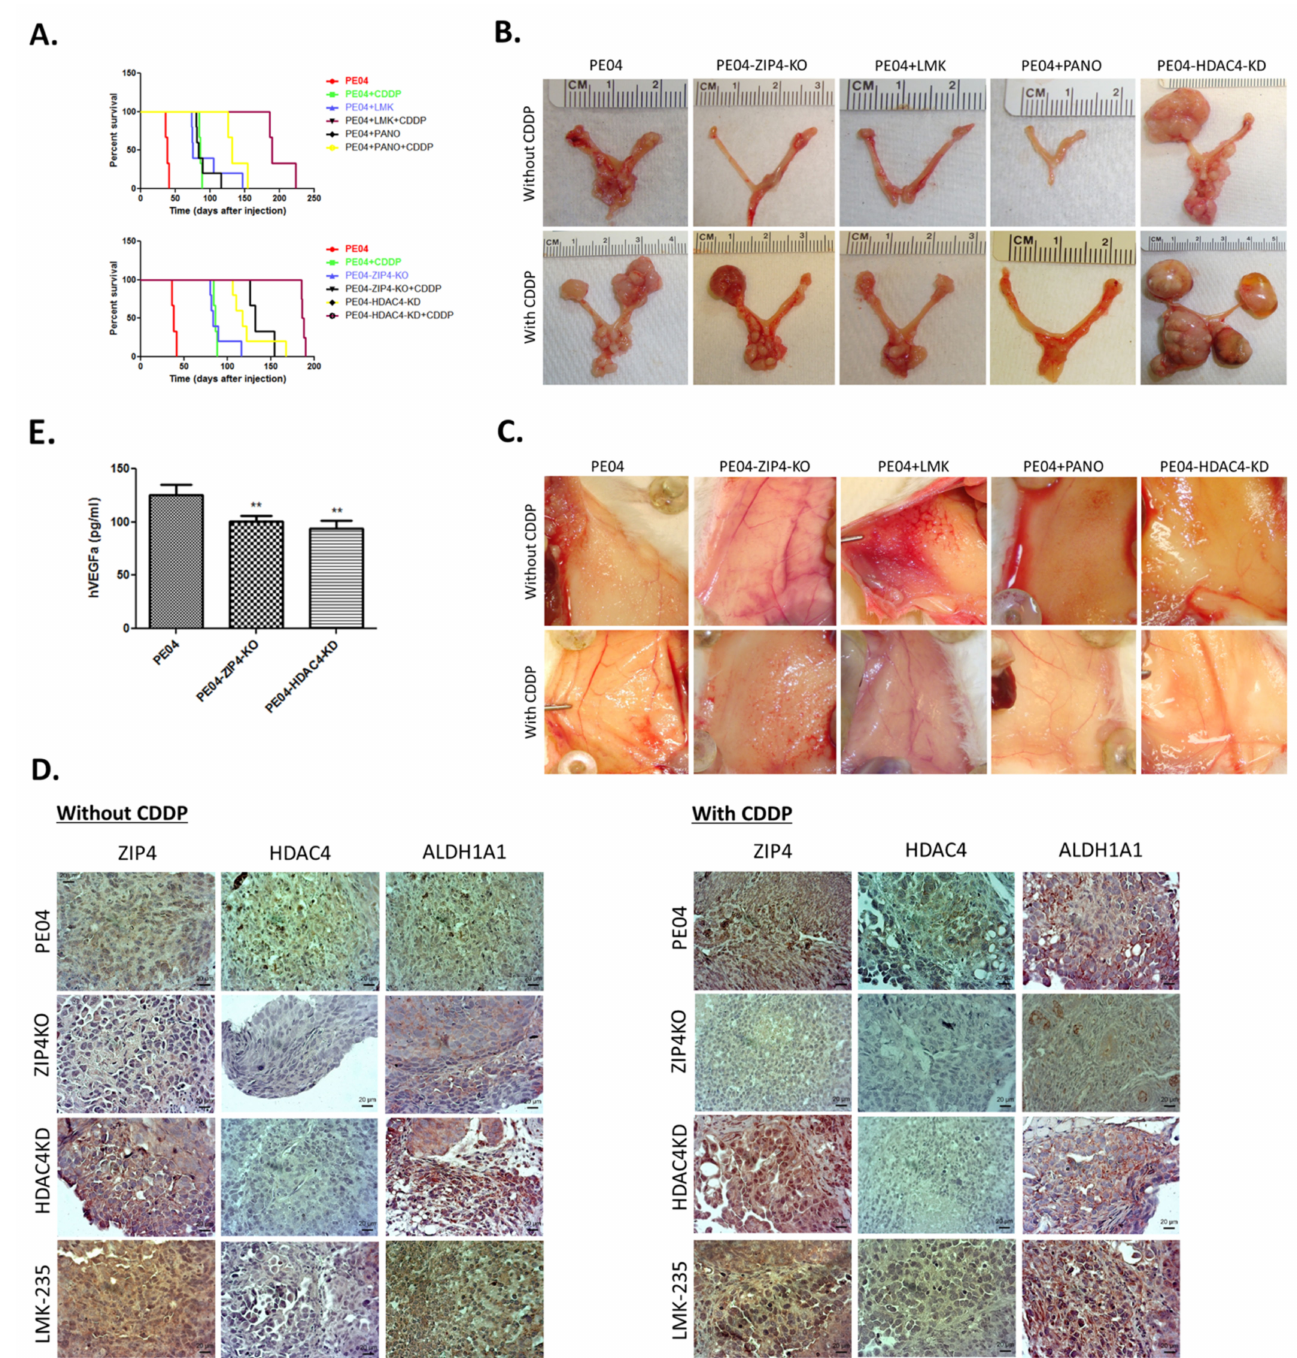
Figure 6. The combinational targeting of the ZIP4-HDAC4 axis and non-CSC using CDDP was highly effective in blocking tumorigenesis. ( A ) The survival curves from each group of mice, with the longest survival groups were those targeting HDAC4. ( B ) Representative tumors on the ovaries and the fallopian tubes from each group of mice. ( C ). Representative tumors on the peritoneal walls (PW) from each group of mice. Even though one or two of the five mice in the PANO and LMK-235 treated groups had low numbers of PW metastases (Table 1), most of them had none on the PW. ( D ). Representative ZIP4, HDAC4, and ALDH1 IHC staining. Magnification was 40 . ( E ). Human VEGFA in ascites in mice. Representative × pictures from three independent experiments are shown. ** p < ≥